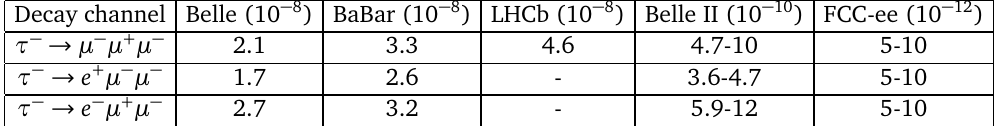
Table 1: Limits for the τ − → µ − µ + µ − , τ − → e + µ − µ − and τ − → e − µ + µ − decays set by the Belle, BaBar and LCHb collaborations. The last two columns stands for the projected sensitivity in Belle II and a tentative circular electron-positron collider. The values of this table have been extracted from [ 12 ]